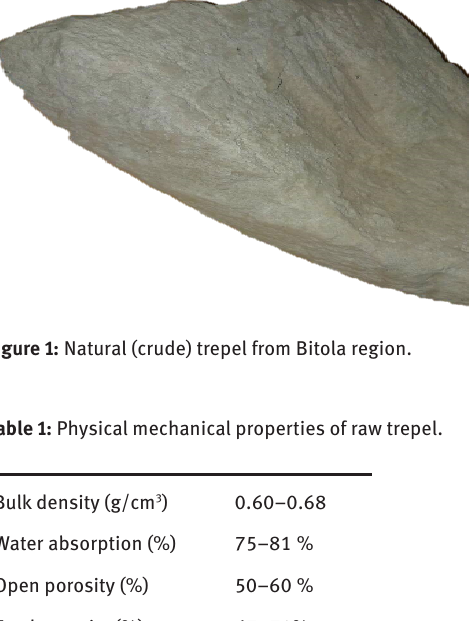
Table 3: Trace elements determined in the naturally occurring